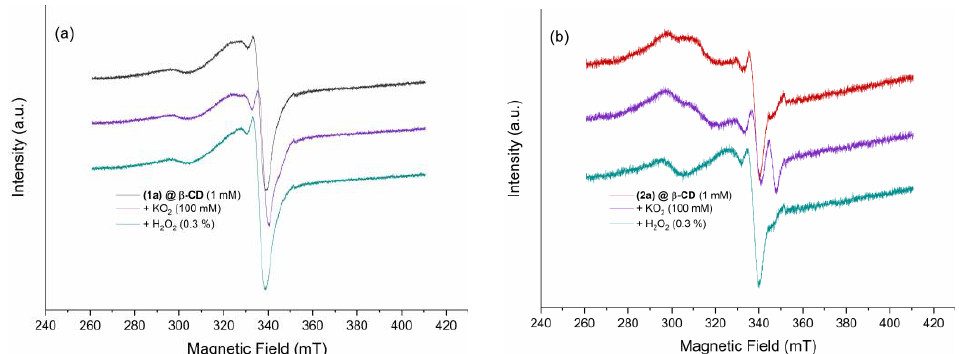
Figure 11. EPR spectra of ( 1a )@ β -CD ( a ) and ( 2a )@ β -CD ( b ) dissolved in DMSO measured at a microwave frequency of 9.88 GHz with a 1 mM concentration also in the presence of ROS donors KO 2 (O 2 · − ) and H 2 O 2 (OH·).